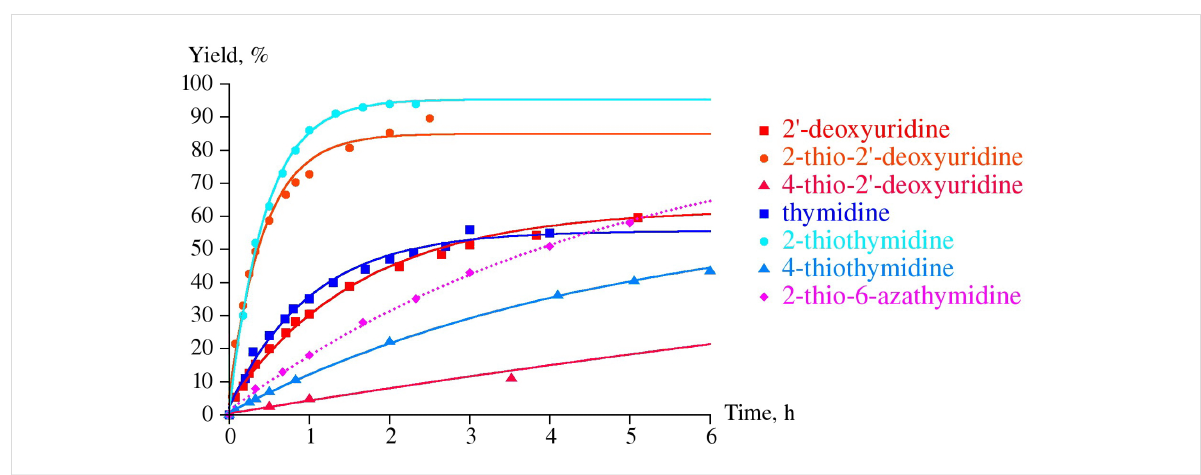
Figure 2: Phosphorolysis of 2 ′ -deoxyuridine and thymidine, their 4- and 2-thio derivatives and 6-aza-2-thiothymidine ( 5b ) catalyzed by E. coli TP (for reaction conditions, see caption of Figure 1. Enzyme : 6.6 × 10 − 4 units of TP was used for all substrates, except for 6-aza-2-thiothymidine, for which 26.5 units of the enzyme was used. Phosphorolysis of 6-aza-2 ′ -deoxyuridine and 6-azathymidine did not exceed a few percent even at high enzyme concentrations and is not presented on the plot.